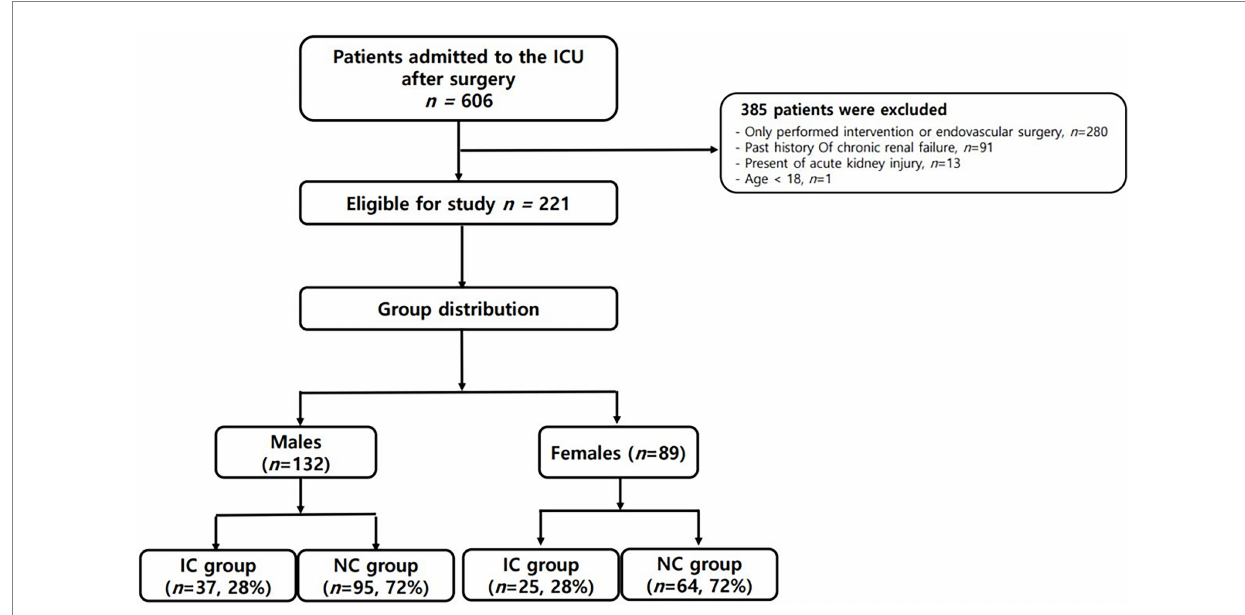
FIGURE 2 Schematic diagram of study enrollment. *IC group: group with infections; ICU: intensive care unit; NC group: group without